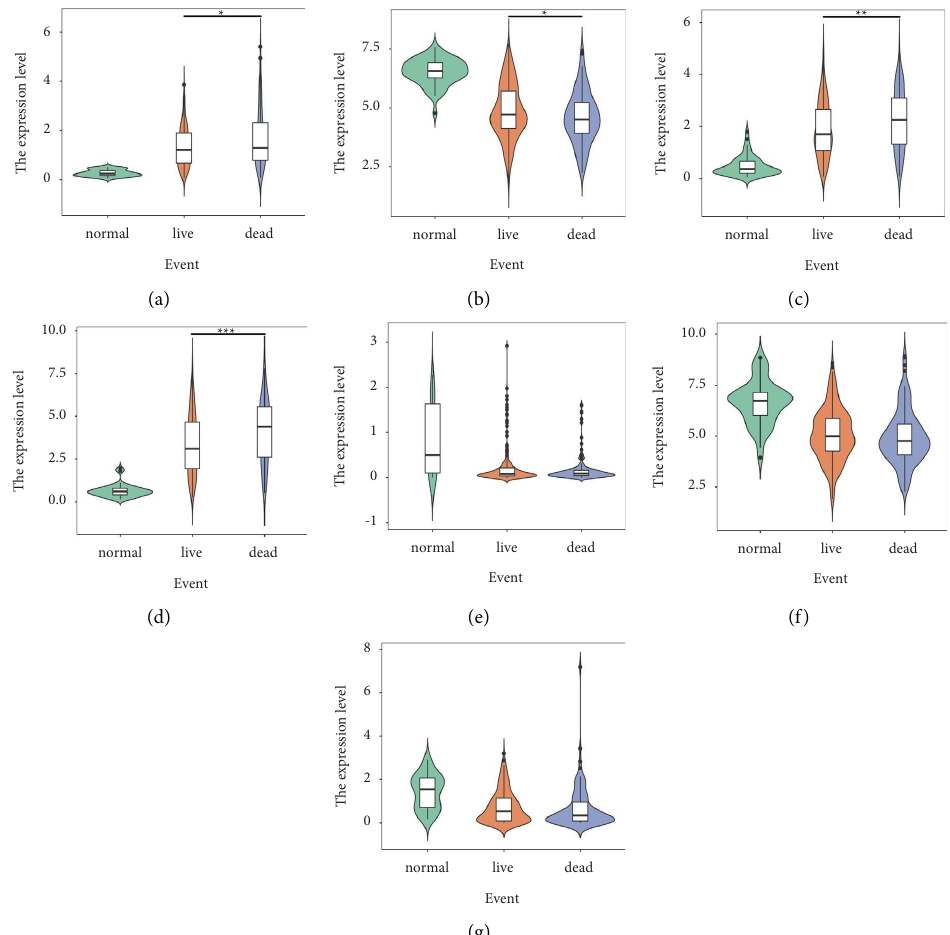
Figure 3: Expression of important DEGs in HCC patients with diferent events: (a) MAFG-DT; (b) GSTZ1; (c) GPRIN1; (d) MYBL2; (e) LINC00907; (f) CCN1; (g) GSTM5 ( ∗ P < 0 . 05, ∗∗∗ P < 0 . 001).